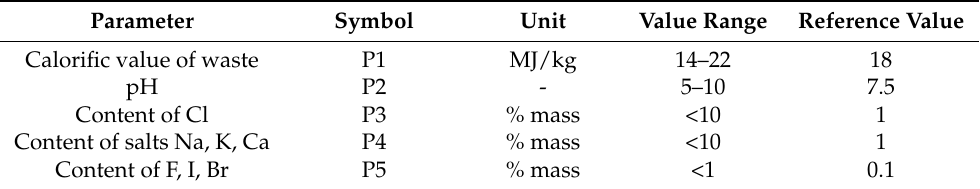
Table 1. Assumptions of the application parameters and their